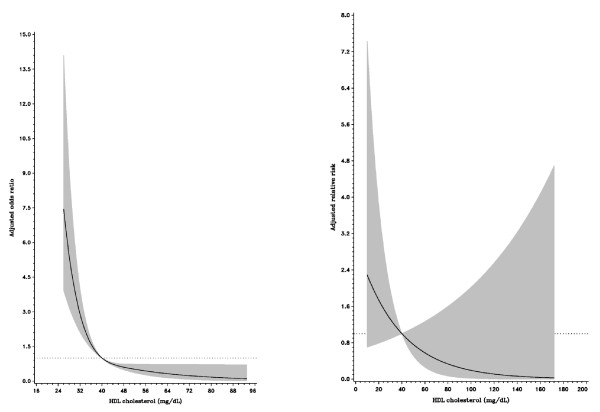
Relationship between HDL-C concentrations and the risk of acute coronary syndrome event (left) and all-cause death after event (right). The multivariate adjusted relative risks were plotted as a function of the baseline HDL-C value with the 95% confidence bands shown as the shaded area.